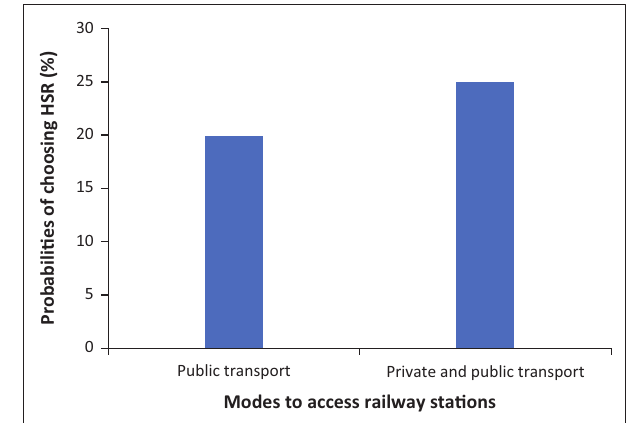
FIGURE 10: Probability of choosing high-speed rail based on